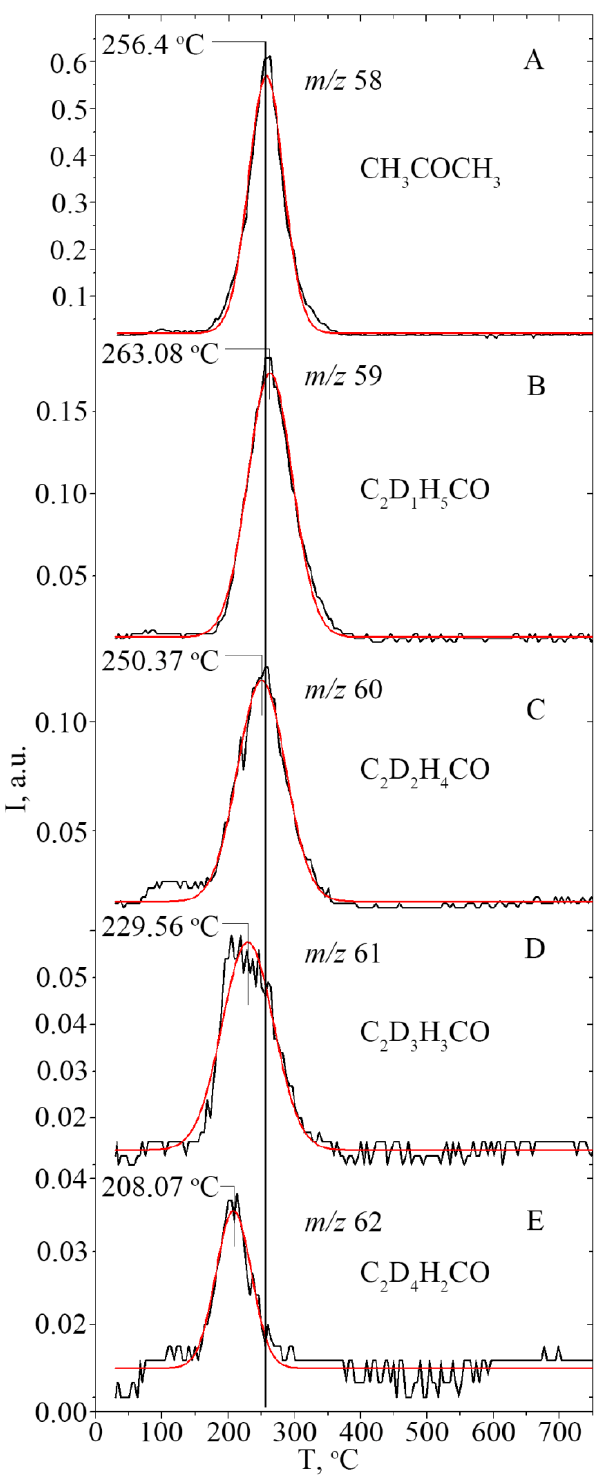
Figure 4. Deconvolution of TPD curve for the ion of acetone with m/z = 58 that was obtained during the pyrolysis of nonlabeled acetic acid on the hCeSi surface ( A ). Deconvolution of TPD-curves for the ions of acetone isotopomers with m/z = 62, 61, 60 and 59 that were obtained during the pyrolysis of deuterated acetic acid on the hCeSi surface ( B – E ). Experimental data is the black line; the fitting curve is the red line.